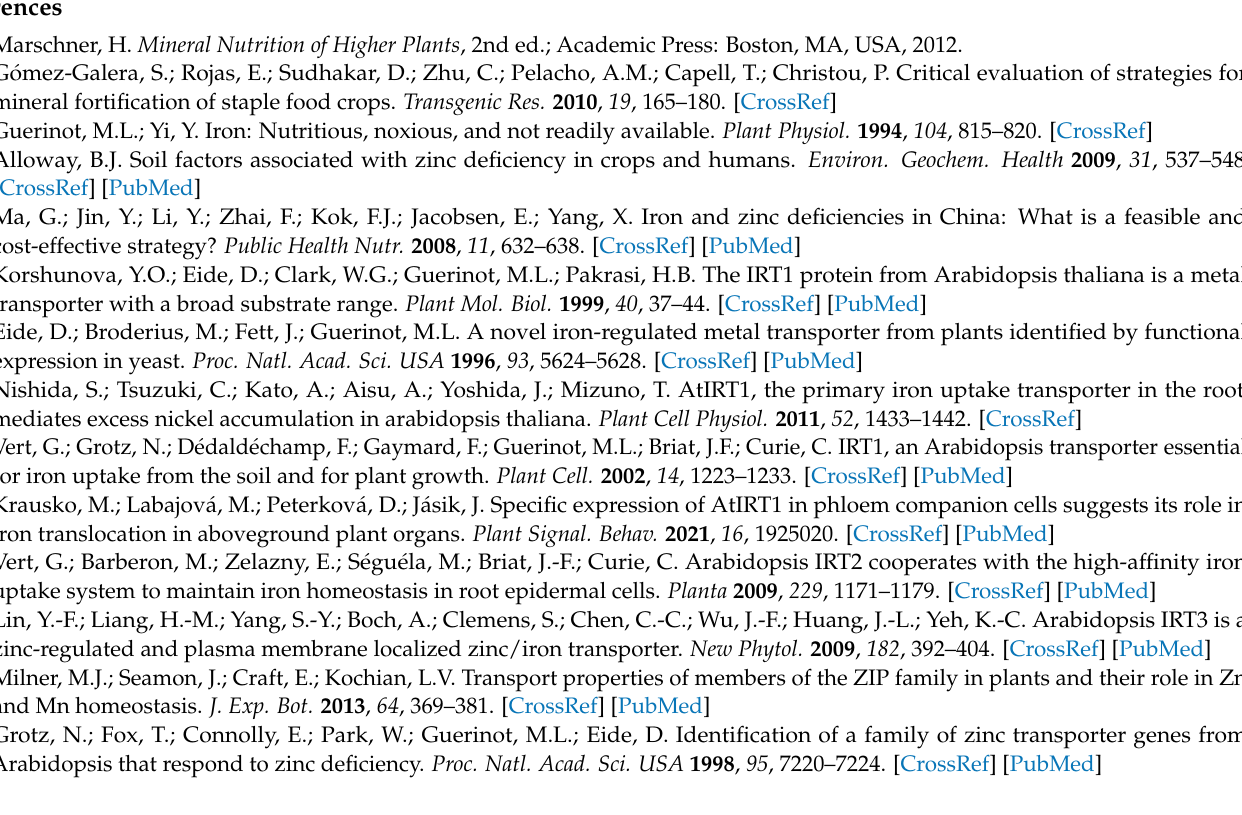
Table S1: Analysis of the ten conserved motifs of AhZIP proteins in peanut; Table S2: The best templates of peanut AhZIP proteins selected from the SwissModel template library for building 3D structure models; Table S3: Expression profiles (TPM) of AhZIP genes in different tissues of peanut; Table S4: Primers of peanut AhZIP genes selected for RT-qPCR